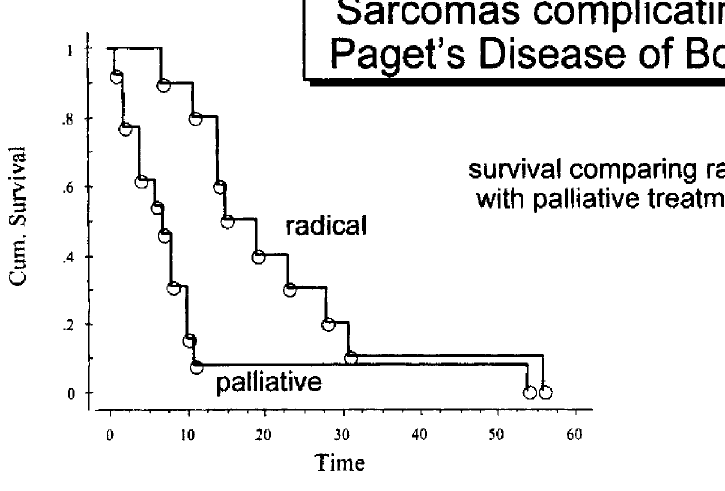
Figure 1. Sarcomas complicating Paget’s disease of